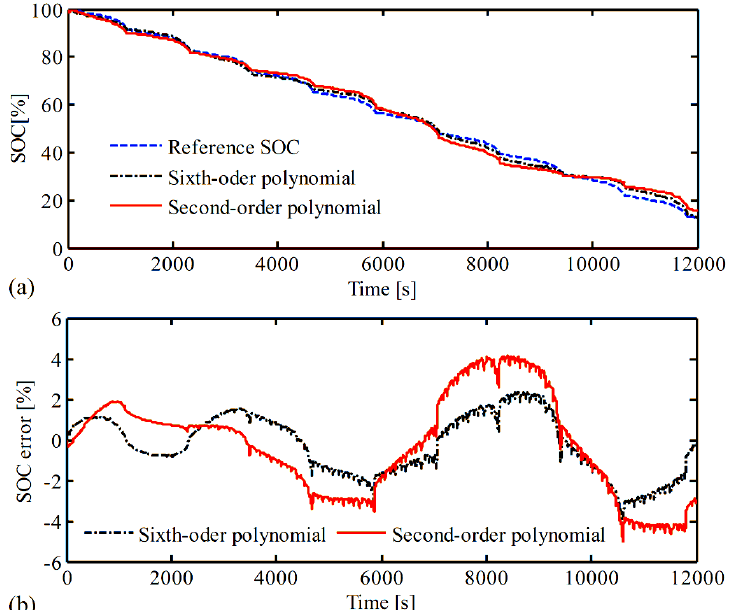
Figure 12. SOC estimation with UKF based on different OCV - SOC relationships under NEDC test: ( a ) SOC ; and ( b ) SOC error.